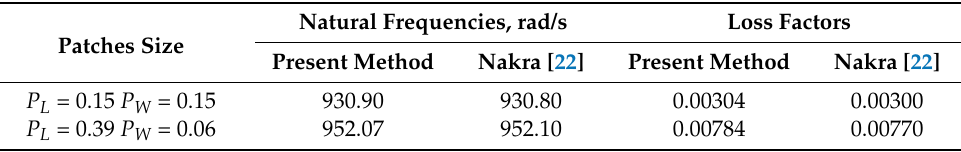
Table 1. First mode natural frequency and loss factor of the partially covered sandwich plate.